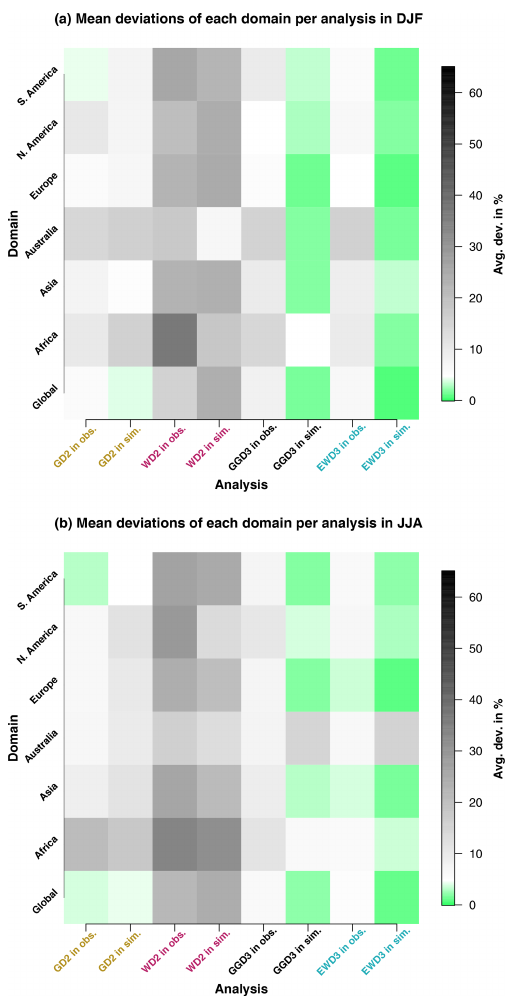
Figure 8. As in Fig. 7 but for the three-parameter exponentiated Weibull distribution (EWD3) – the best-performing candidate dis- tribution function in this study –, a baseline which uses the two- parameter gamma distribution (BL2), and a frequently proposed multi-PDF SPI calculation algorithm that uses in each grid point and season that distribution function that yields in the respective grid point and during the respective season the minimum AIC value (AIC min -analysis which is denoted as AIC min in this figure). In contrast to GD2 in our previous analysis, BL2 employs a simpler optimization procedure of the same parameter estimation method ( maximum-likelihood estimation